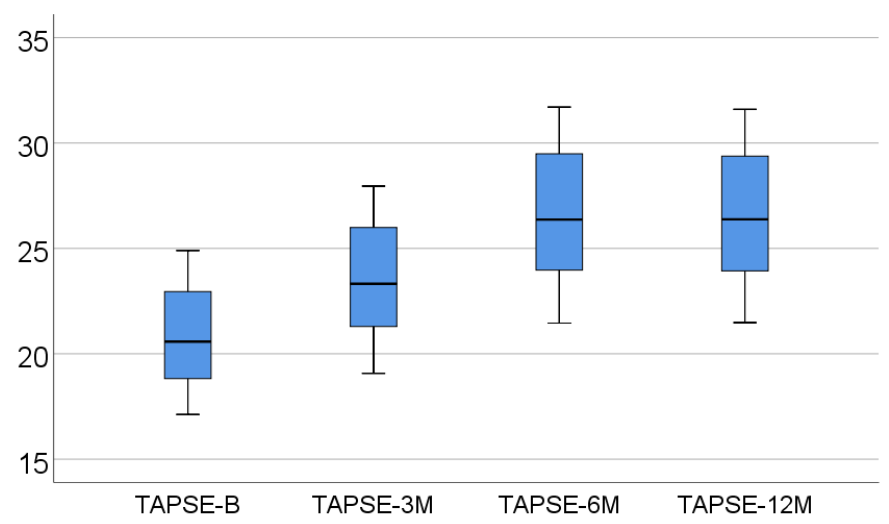
Figure 3. Box-plot representation of TAPSE evolution.